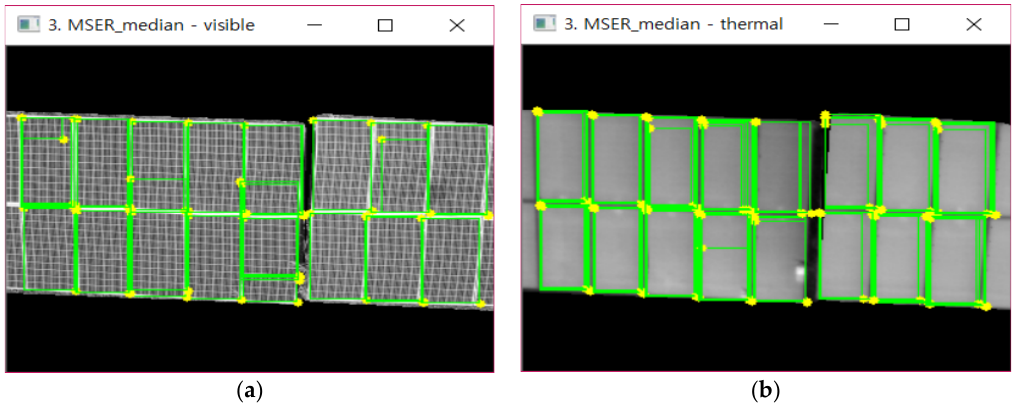
Figure 10. MSER algorithm and feature point detection result considering module size: ( a ) result of visible image; ( b ) result of thermal image.